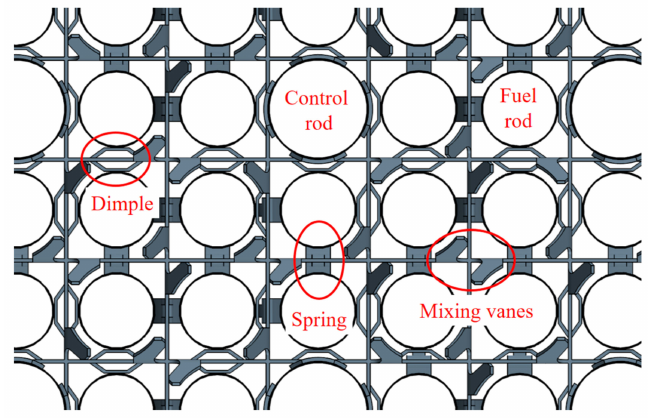
Figure 2. Geometric model of a mixing